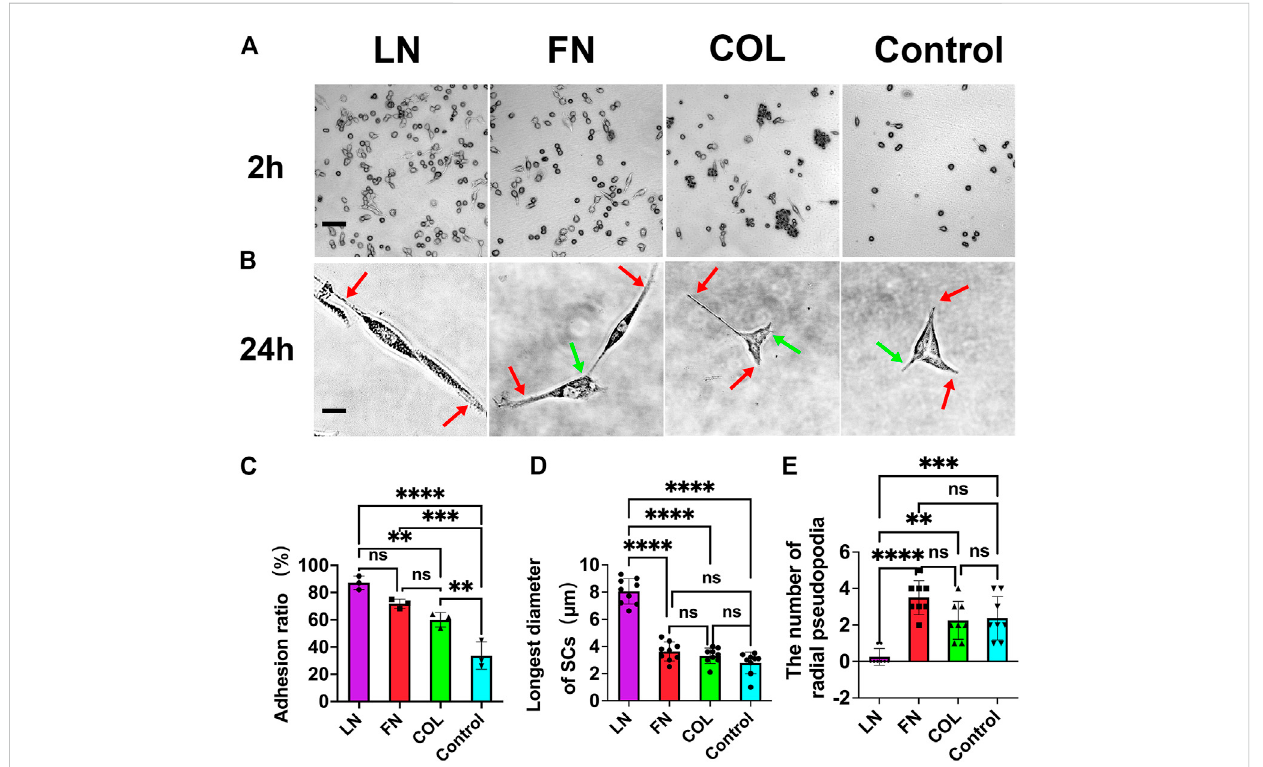
FIGURE 2 Adhesion and cell morphology ofSCs in early2D culture conditions. The adhesion of SCs at2 hafter seeding (A) and themorphology ofSCs at 24 h after seeding (B) : axial pseudopodia (red arrow) and radial pseudopodia (green arrow). The adhesion ratio in the LN group was signi fi cantly higher than thatintheothergroups( p < 0.01)[ (C) , n =3].MajoraxisofSCs(themaximumlengthofasinglecell)intheLNgroupwassigni fi cantlylargerthanthatinthe FN group and type IV Col group ( p < 0.0001) [ (D) , n = 9]. The number of radial pseudopodia of SCs in the LN group was signi fi cantly less than that of SCs in the FN group and IV Col group ( p < 0.01) [ (E) , n = 8]. ** p < 0.01, *** p < 0.001, **** p < 0.0001, ns p > 0.05. One-way ANOVA with Tukey ’ s post hoc test. Scale bar (A) = 10 µm. Scale bar (B) = 1